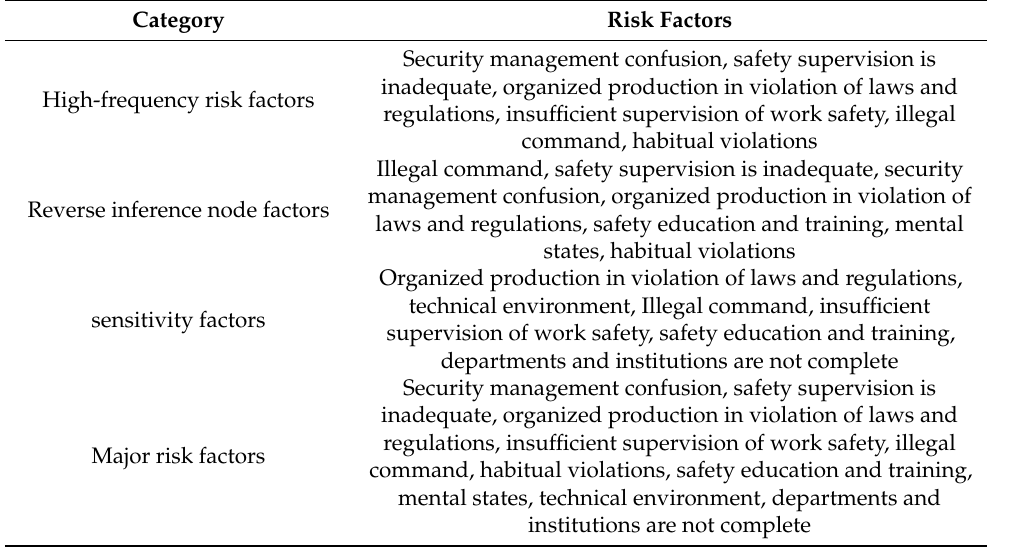
Table 10. Summary of major risk